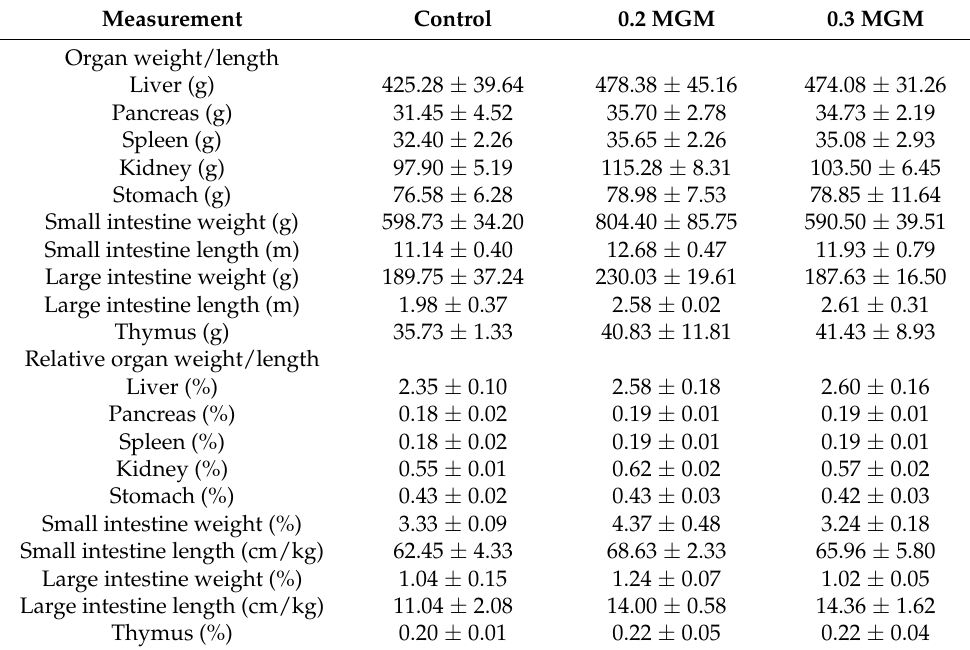
Table 6. Effects of MGM-P supplementation on the organ weight/length of weaned